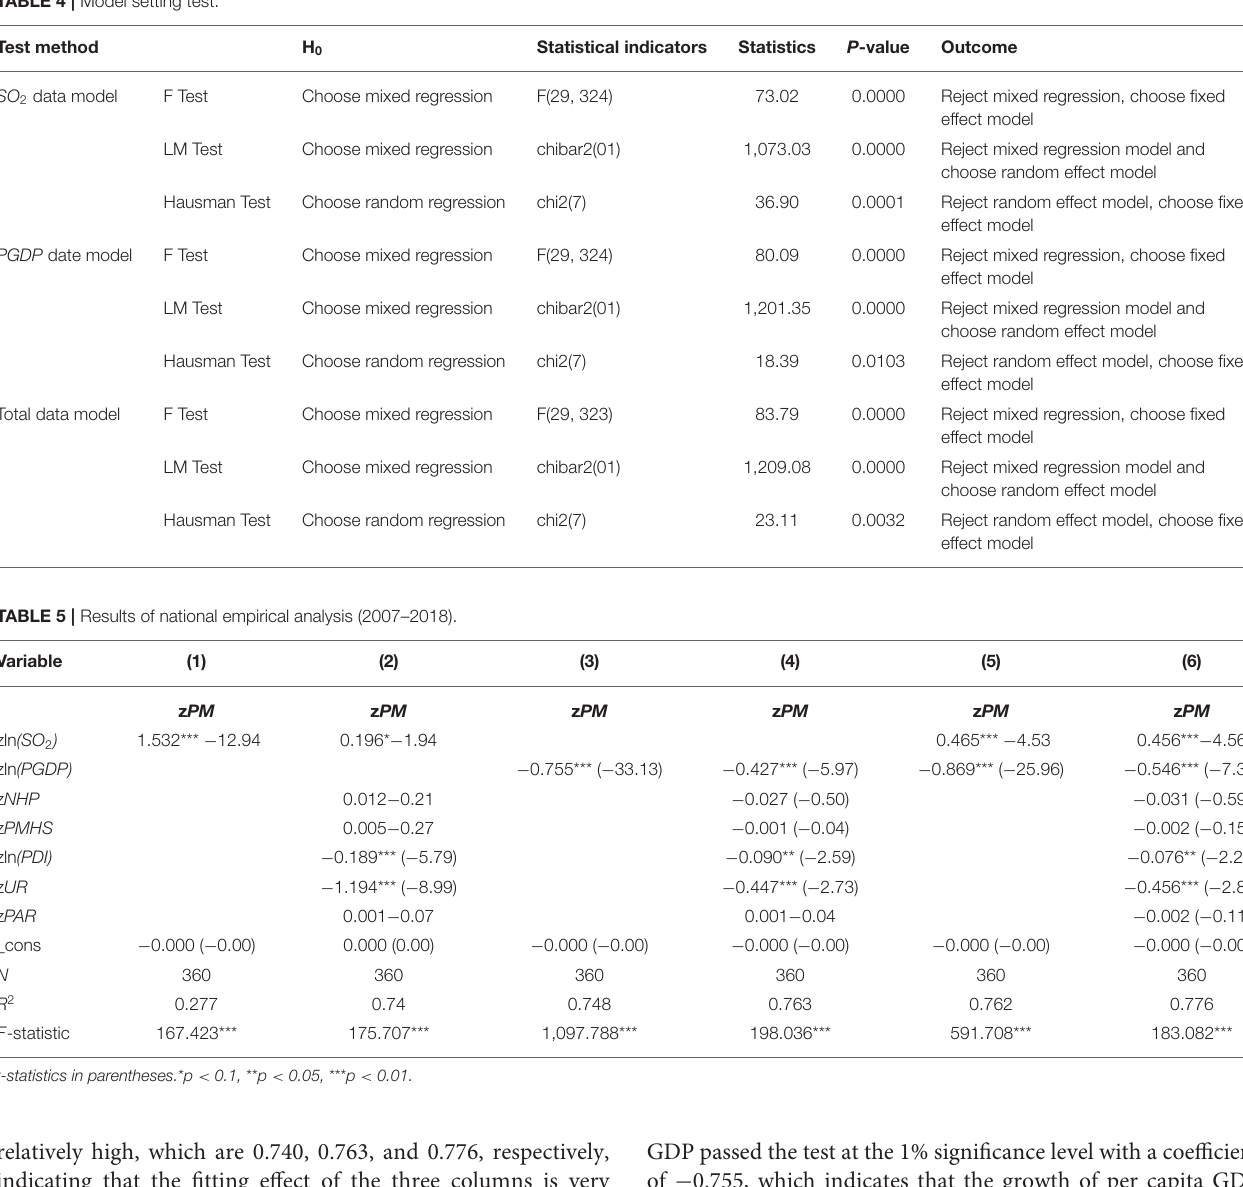
TABLE 4 | Model setting test.